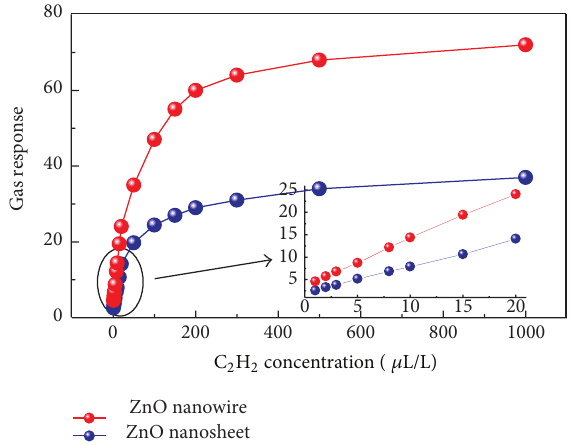
Figure 6: Gas response of the sensors to different C 2 H 2 gas concen- trations (1–1000 𝜇 L/L) at 550 K; the inset shows the corresponding sensor response curve (1–20 𝜇 L/L).